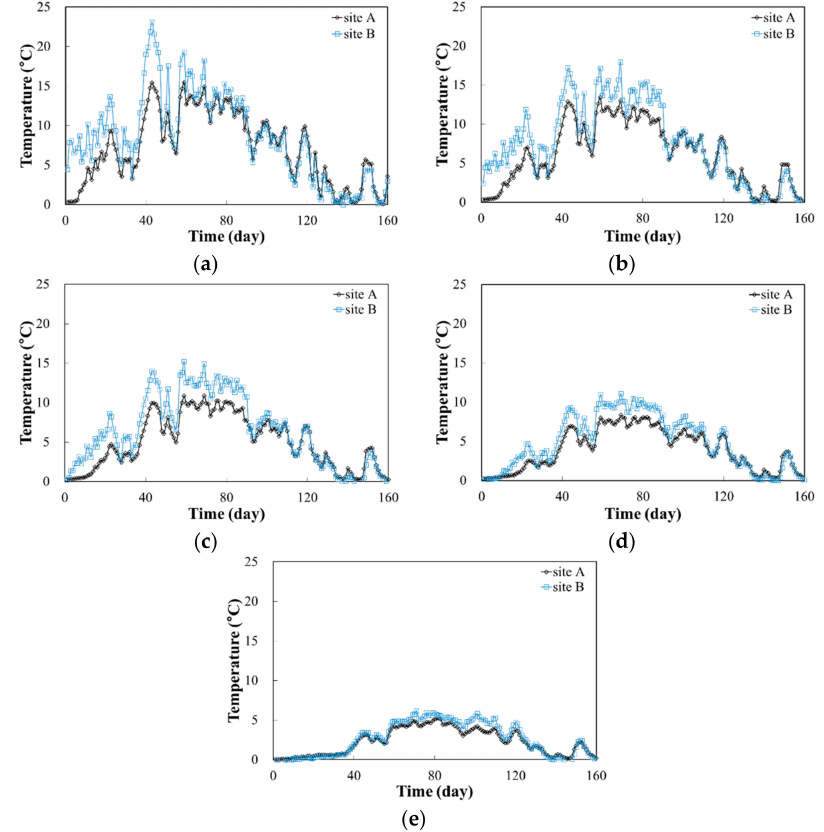
Figure 4. Measured soil temperatures at different depths at the sites A and B: depths of ( a ) 5 cm; ( b ) 10 cm; ( c ) 15 cm; ( d ) 20 cm; and ( e ) 30